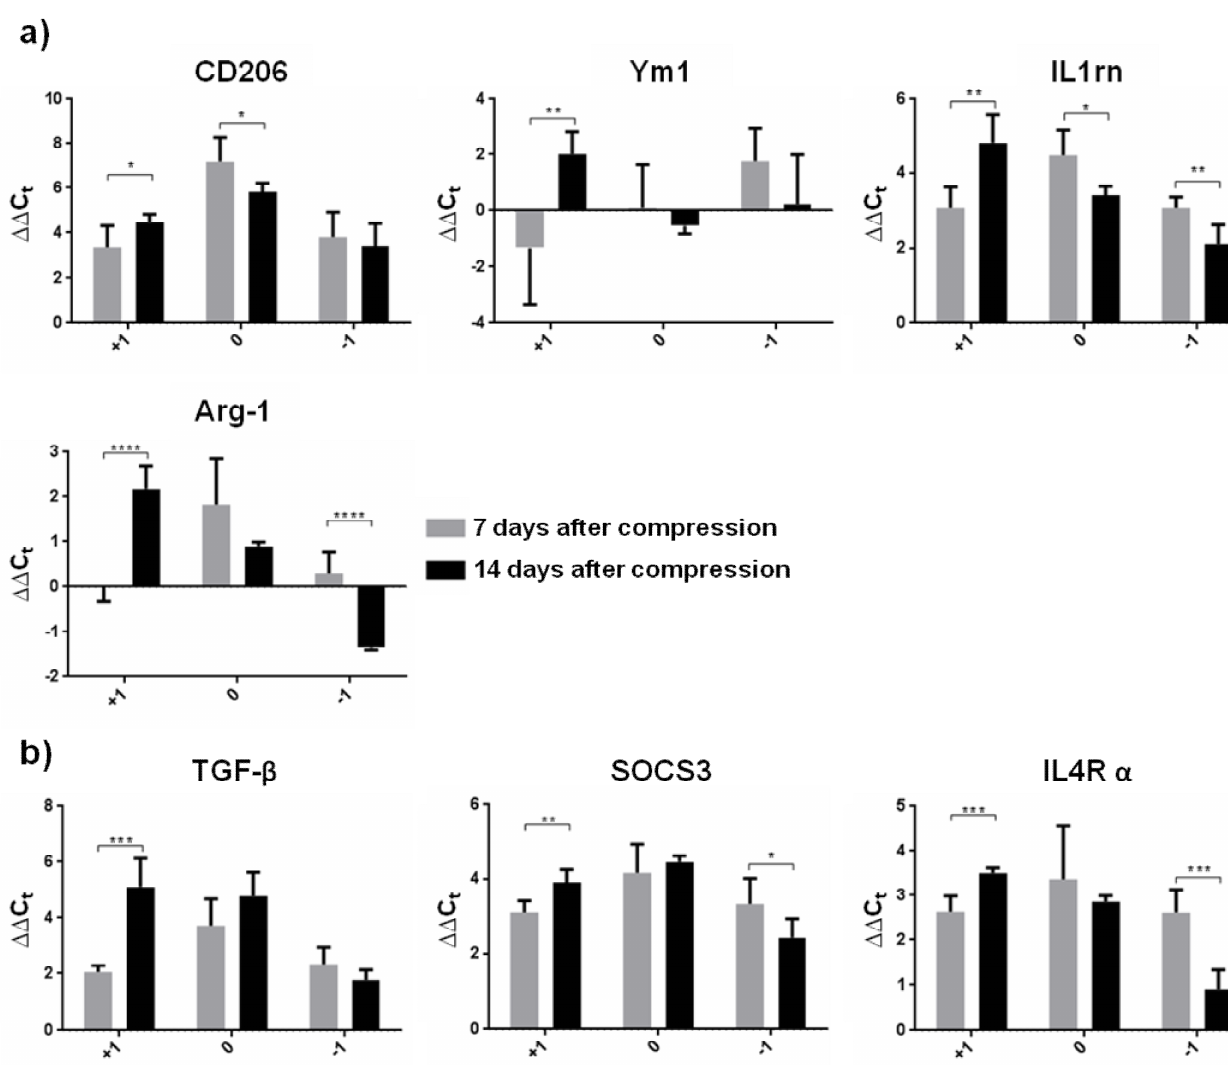
Figure 4. Graphs demonstrating relative gene expression of neuroprotective microglia in the spinal cord (injury site, cranially and caudally) one and two weeks after Th9 compression. ( a ) M2a subtype of activated microglia represented by CD206, Ym1, IL1rn and Arg-1; ( b ) M2c subtype of activated microglia markers (TGF- β , SOCS3 and IL4R α ). Data are mean values of five experiments ± SD. The mRNA levels for each marker were normalized to the mRNA levels of 18sRNA and expressed as ∆∆ C t values relative to controls. Results were statistically evaluated using unpaired t -test; * p < 0.05; ** p < 0.01; *** p < 0.001; **** p < 0.0001. CD206—mannose receptor and C-type lectin; Ym1—chitinase-like protein-1; IL1rn—interleukin 1